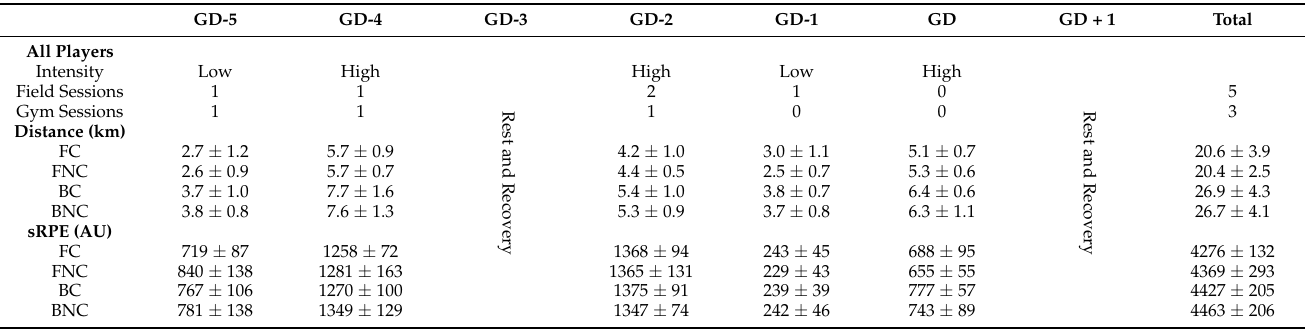
Table 1. Overview of the seven-day competition week in catered and non-catered